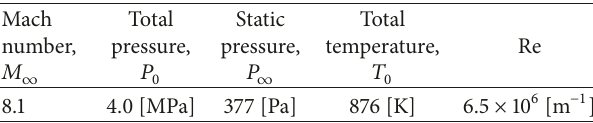
Table 1: Test flow